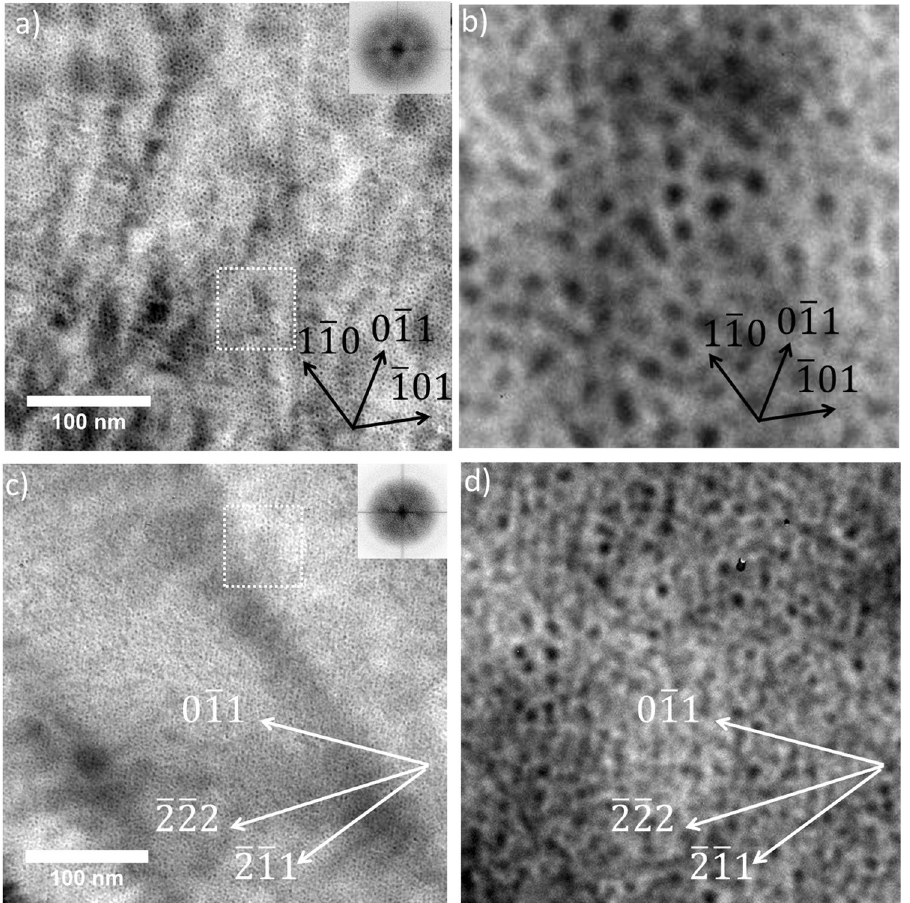
Figure 5. W sample irradiated with 15 keV He ions at 773 K up to 1.1 × 10 17 ions.cm − 2 to 3.0 DPA: ( a ) BF-TEM image of a He bubble lattice close to the [111] zone axis with inset showing the corresponding FFT; ( b ) enlarged region of white dashed box in (a); ( c ) BF-TEM image of He bubble lattice close to the [011] zone axis with inset showing the corresponding FFT; and ( d ) enlarged region of white dashed box in